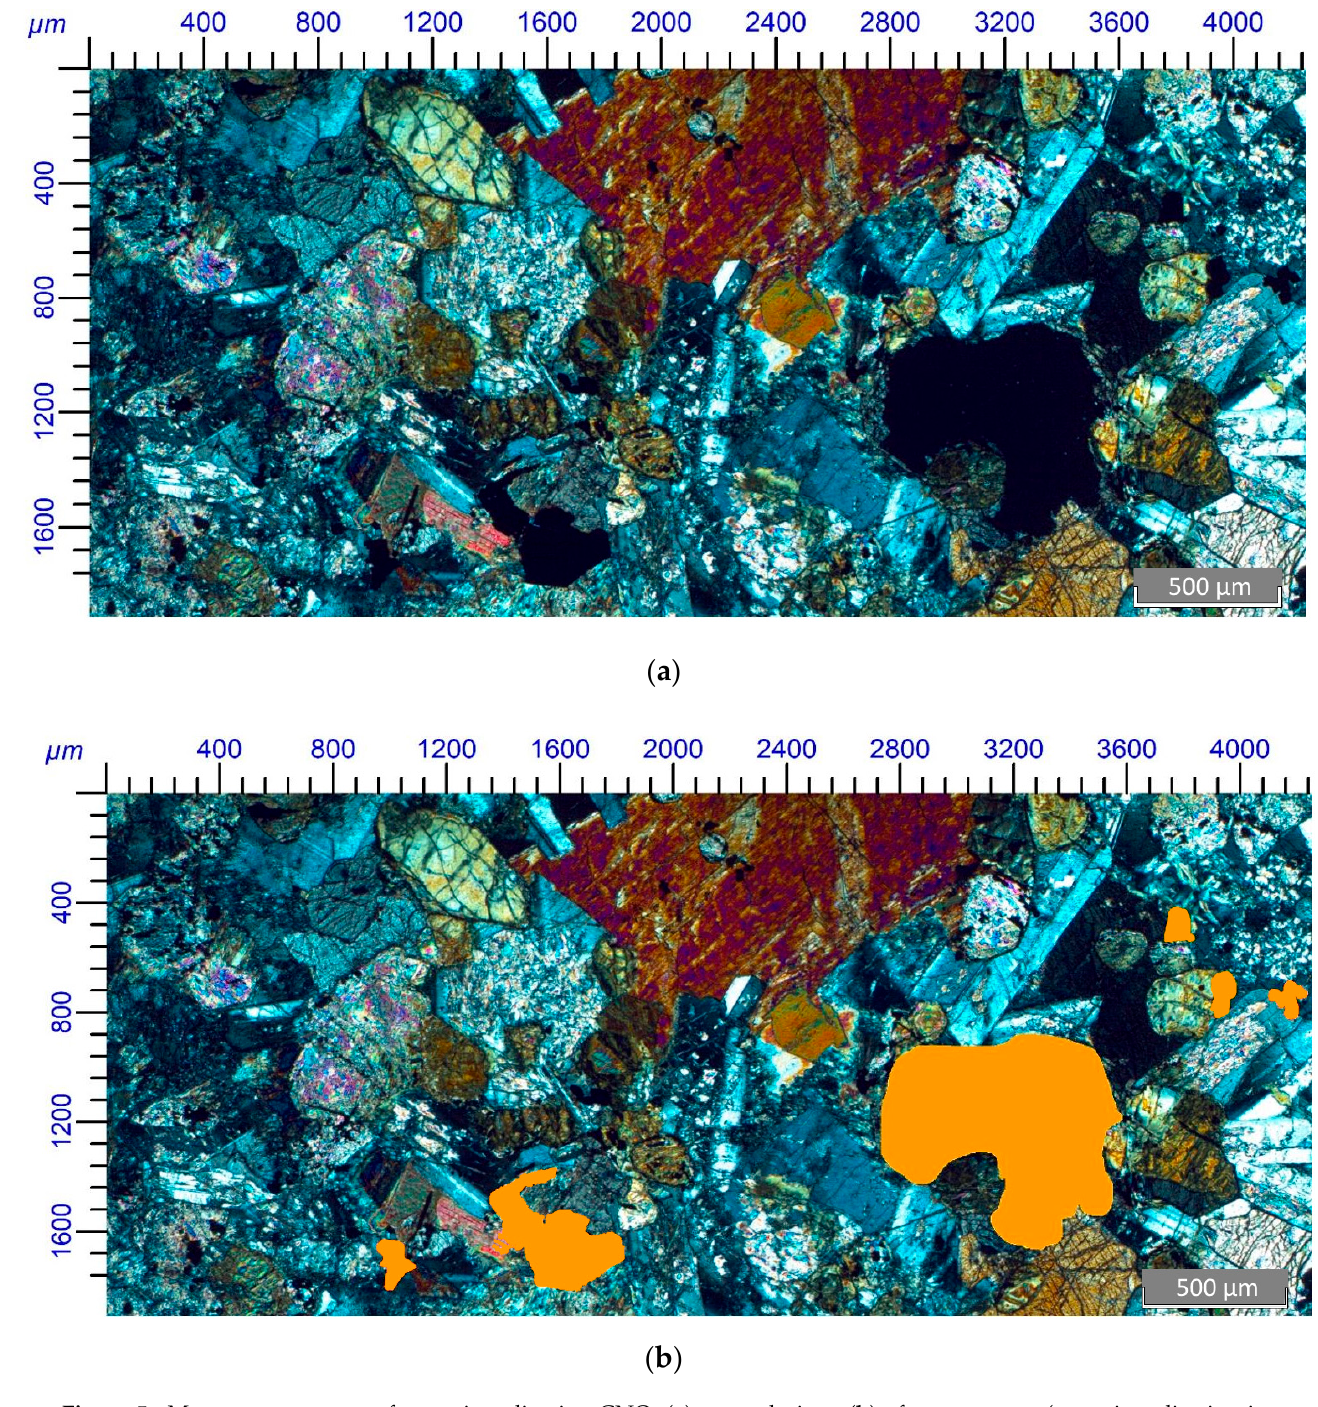
Figure 5. Measurement areas of ore mineralization CNO: ( a ) general view; ( b ) after treatment (ore mineralisation is highlighted in orange color). Table 4. The results of linear measurements for ore mineralization CNO and BDO.